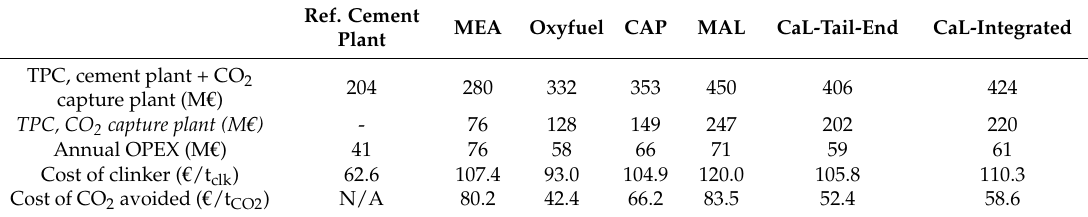
Table 6. Summary of total plant costs and economic KPIs for the reference cement plant and the CO 2 capture technologies.